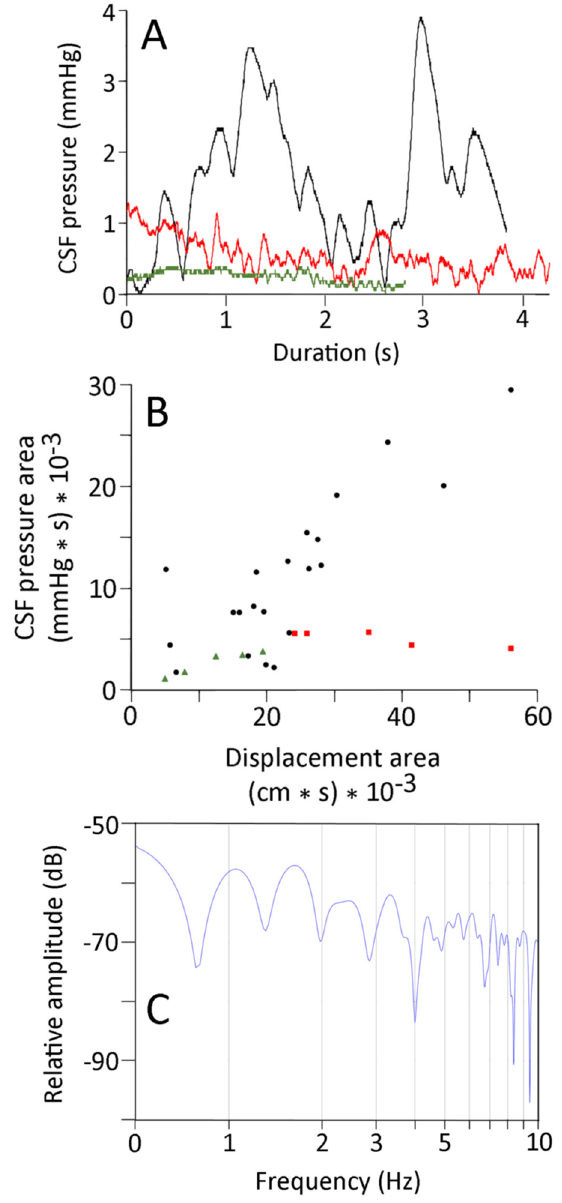
Figure 6. ( A ) CSF pressure traces recorded from the same specimen of Candoia during manual oscillations (black trace), undulatory locomotion (red trace), and concertina locomotion (green trace). The traces have not been adjusted to equal lengths, but are presented with the same Y-axis scale. ( B ) Comparison of the area under the kinematic displacement curve (X-axis) and the area under the CSF pressure curve (Y-axis) for the manual oscillation (black circles), undulatory locomotion (red squares), and concertina locomotion (green triangles). Note that the concertina locomotion trials fall on the low end of both the displacement and CSF pressure scales. ( C ) Power spectral analyses of CSF pressure data from an undulatory locomotor trial; note the relative simplicity of the power